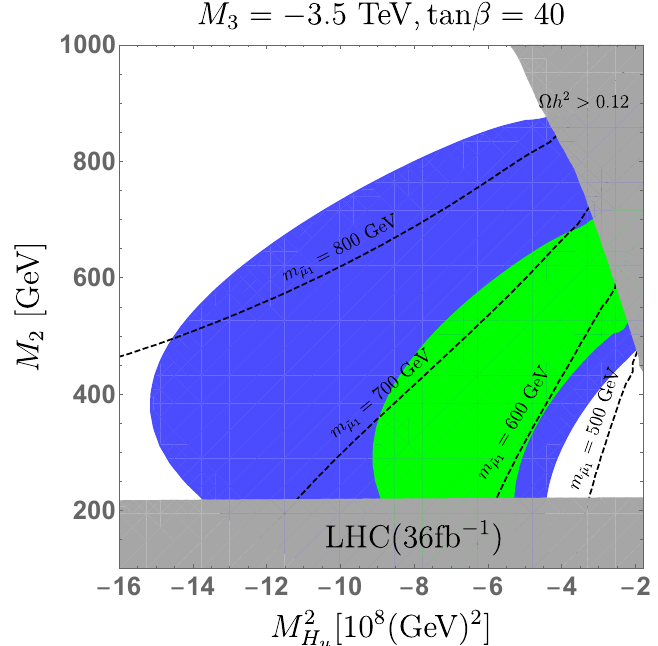
Figure 4 . Region of parameter space where the dark matter abundance is obtained via ~ B (cid:0) ~ W co-annihilation. The green (blue) regions are consistent with the muon g (cid:0) 2 at 1(2) (cid:27) . The lower grey region is excluded by compressed chargino searches [55]. In the upper grey region it is not possible to obtain the correct relic